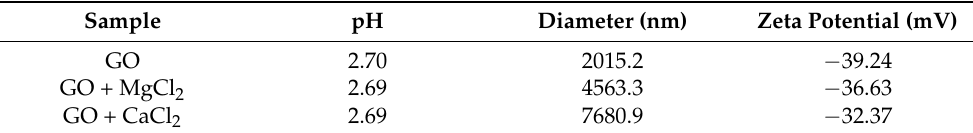
Table 1. Properties of the GO colloidal suspension in the presence of MgCl 2 and CaCl 2 .